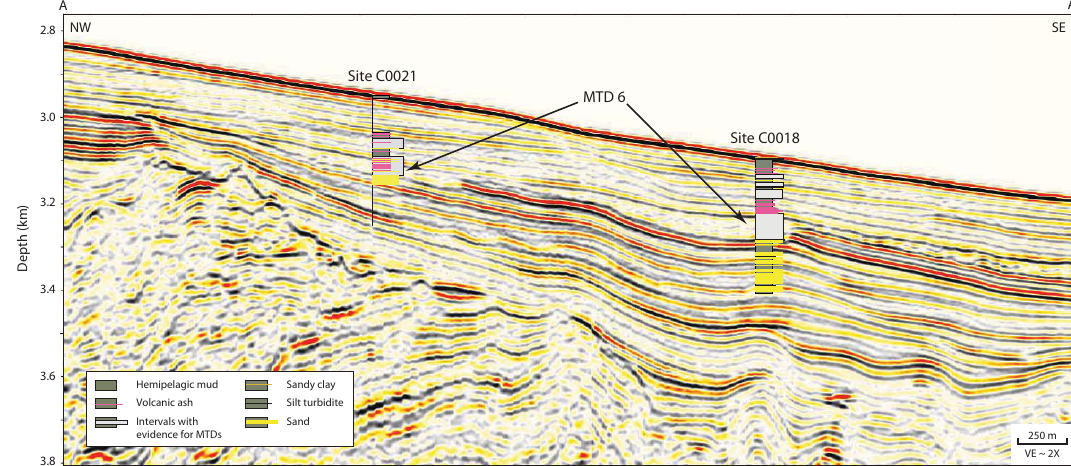
Figure 4. Lithostratigraphic summary columns of sites C0018 and C0021 overlain on an arbitrary seismic line A–A 0 linking the two sites. Seismic line location shown in Fig. 3. MTD = mass transport deposit, VE = vertical exaggeration.